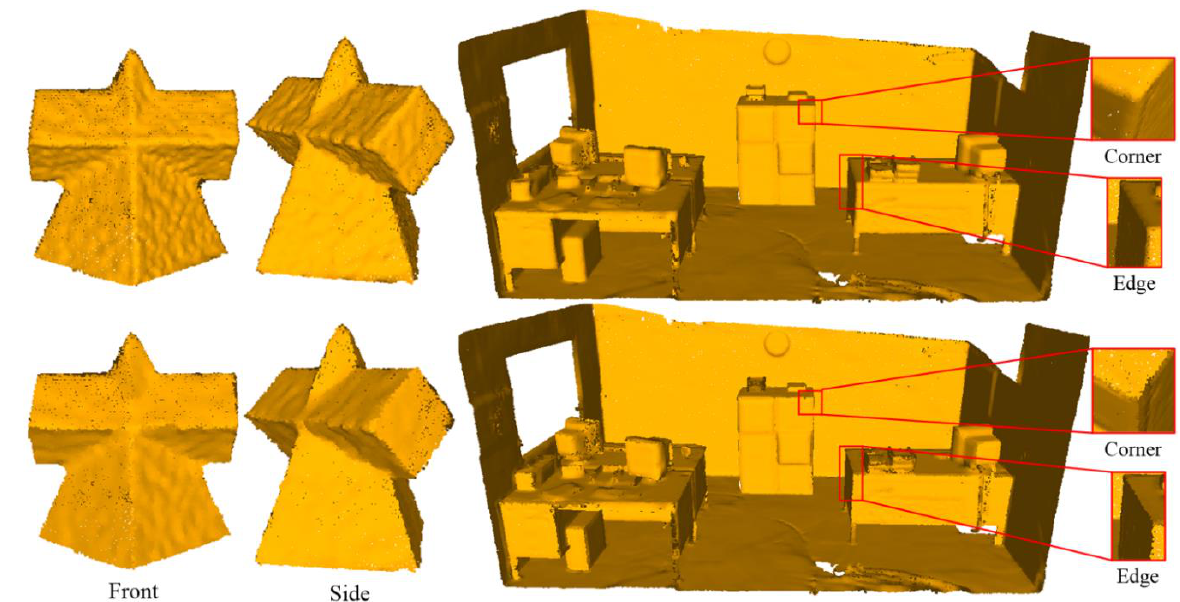
Figure 11. The normal estimation results on real scan data. The result of PCA is shown in the top row, and the result of the proposed method is shown in the bottom row.